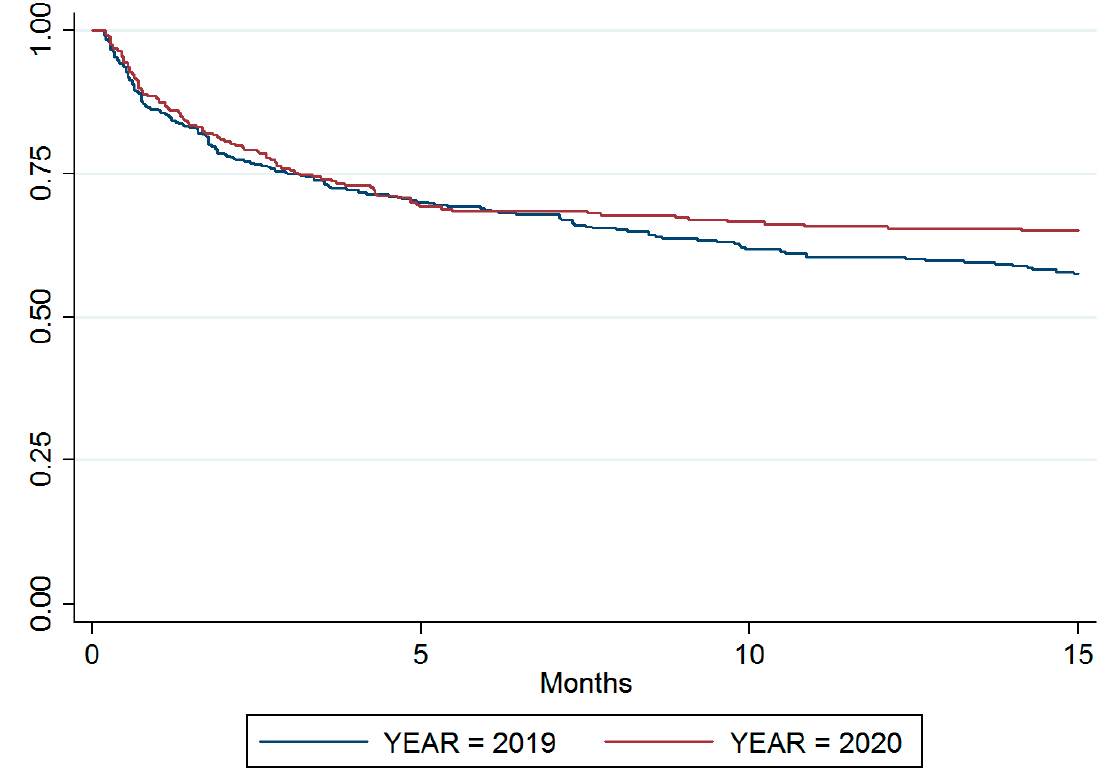
Figure 5. Kaplan–Meier plot. Survival curves of patients admitted in 2019 and 2020 follow-up during 15 moths after admission. No significant differences in survival rates among the two groups was observed (Log-Rank p = 0.124).